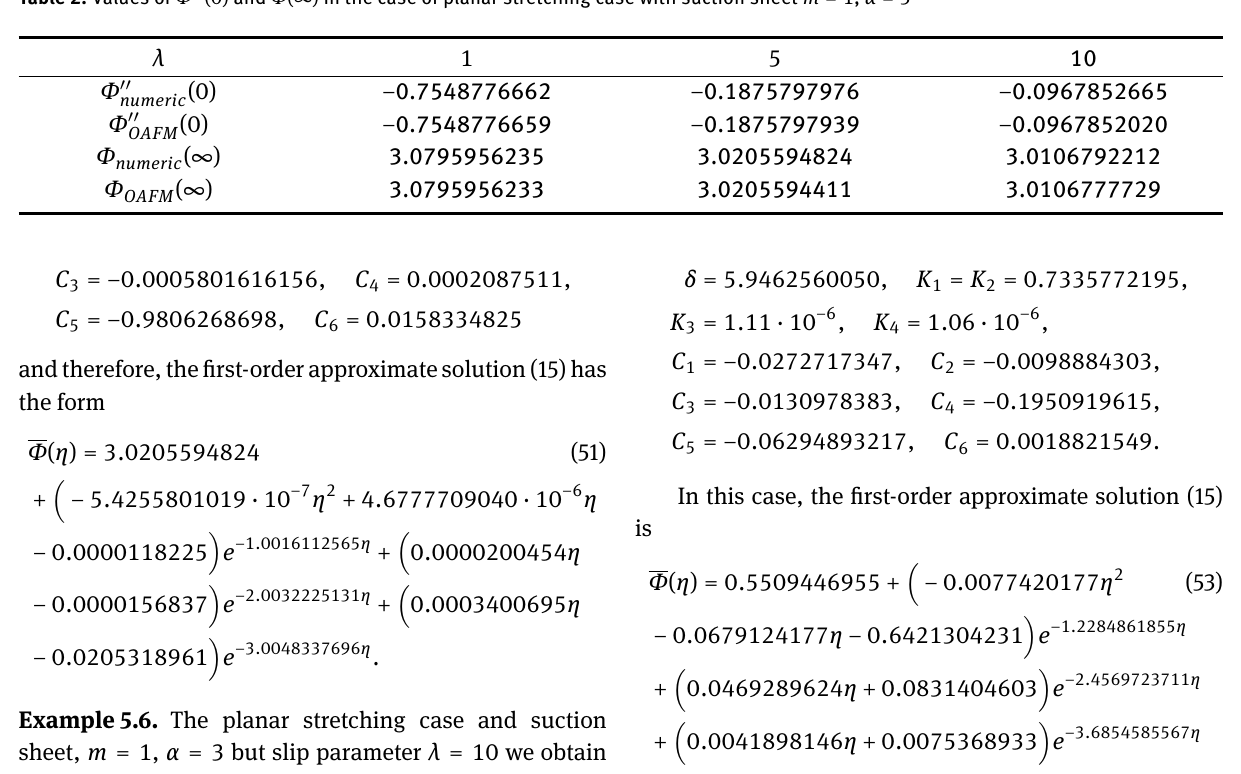
Table 2: Values of Φ ′′ (0) and Φ (∞) in the case of planar stretching case with suction sheet m = 1 , α =